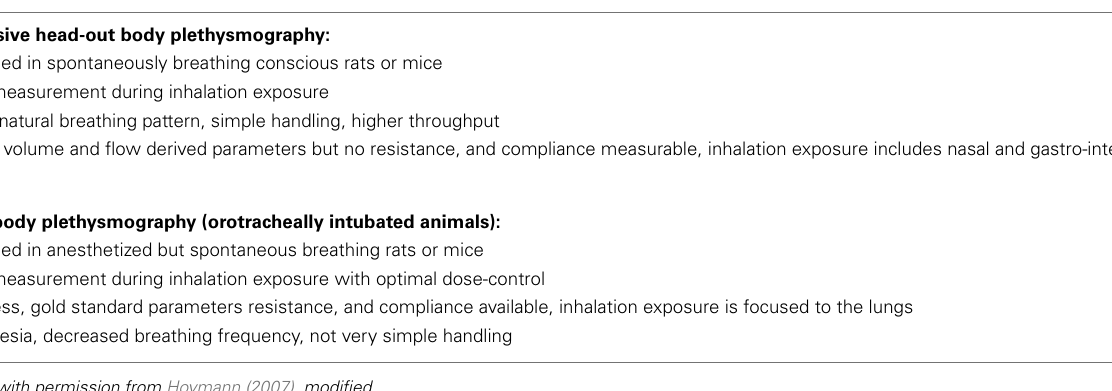
Table 2 |Advantages and disadvantages of a non-invasive and an invasive plethysmographic